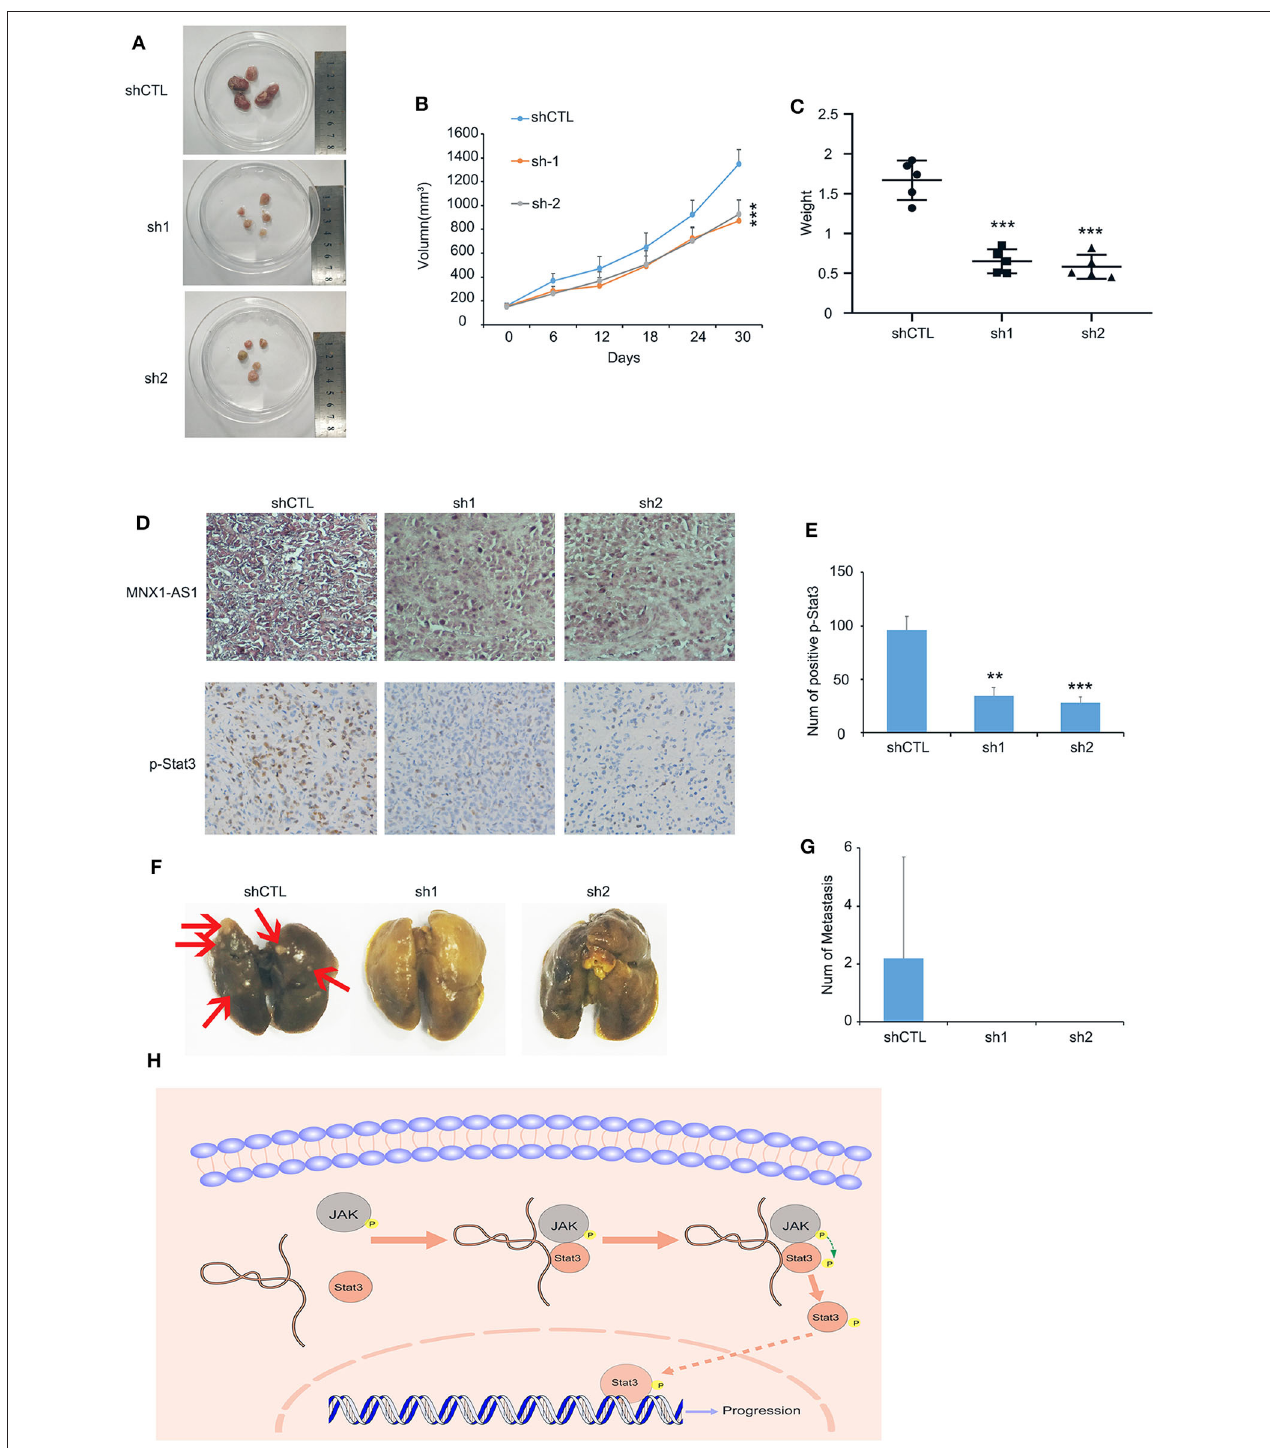
FIGURE 4 | MNX1-AS1 promotes progression of TNBC in vivo . (A–C) Tumor image, growth curve and weight of MDA-MB-231 xenografts in nude mice, MDA-MB-231 transfected with control Plko-tet-on-shRNA (as Vector) or Plko-tet-on-shMNX1-AS1 (as shMNX1-AS1) were injected subcutaneously into mammary fat pad of nude mice. Nude mice were fed with doxycycline (doxy) (2 mg/ml) to induce MNX1-AS1 knockdown Xenografts were harvested 30 days after tumor size reach about 200 mm 3 . Error bars show ± SD ( n = 5 per group). (D) Representative image of MNX1-AS1 and p-stat3 staining in paraffin-embedded xenograft sections.